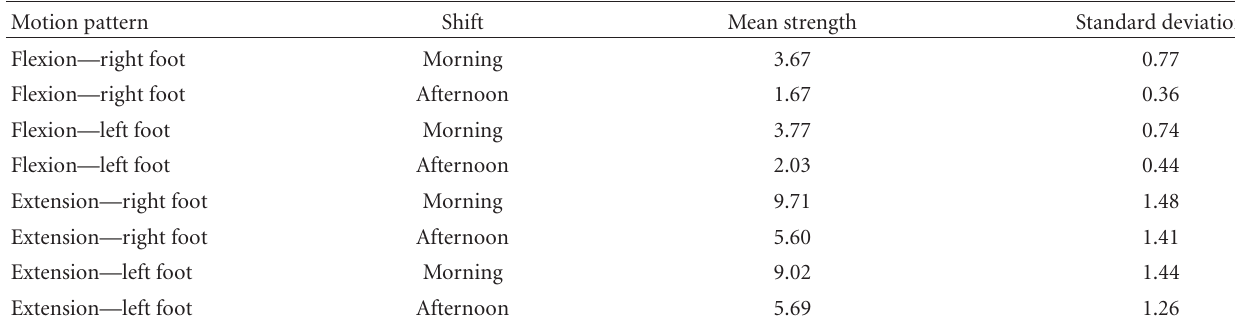
Table 2: Strength generated in each